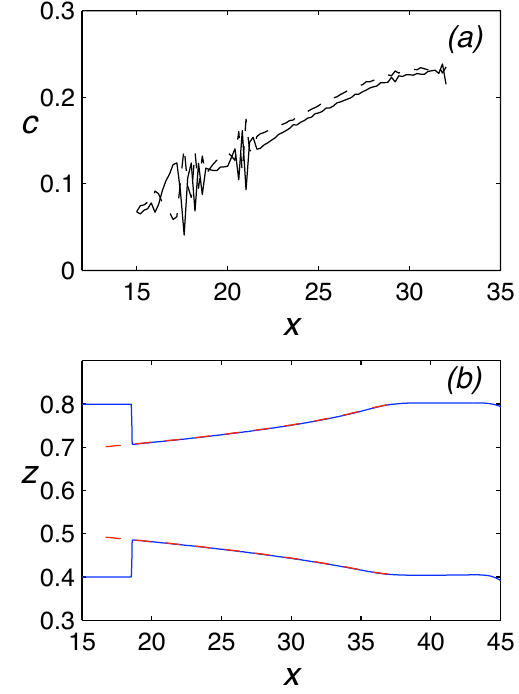
Fig. 11. Layer interfaces from the three-layer numerical solution for D 1 = 0 . 4, D 2 = 0 . 4, and D 3 = 0 . 2, and 1 3 / 2 = 1 5 / 2 = 0 . 5. The initial condition is given by Eqs. (28) and (29) with a 0 = 0 . 25 and b = 1 / 3 and the vertical structure from the second vertical mode.